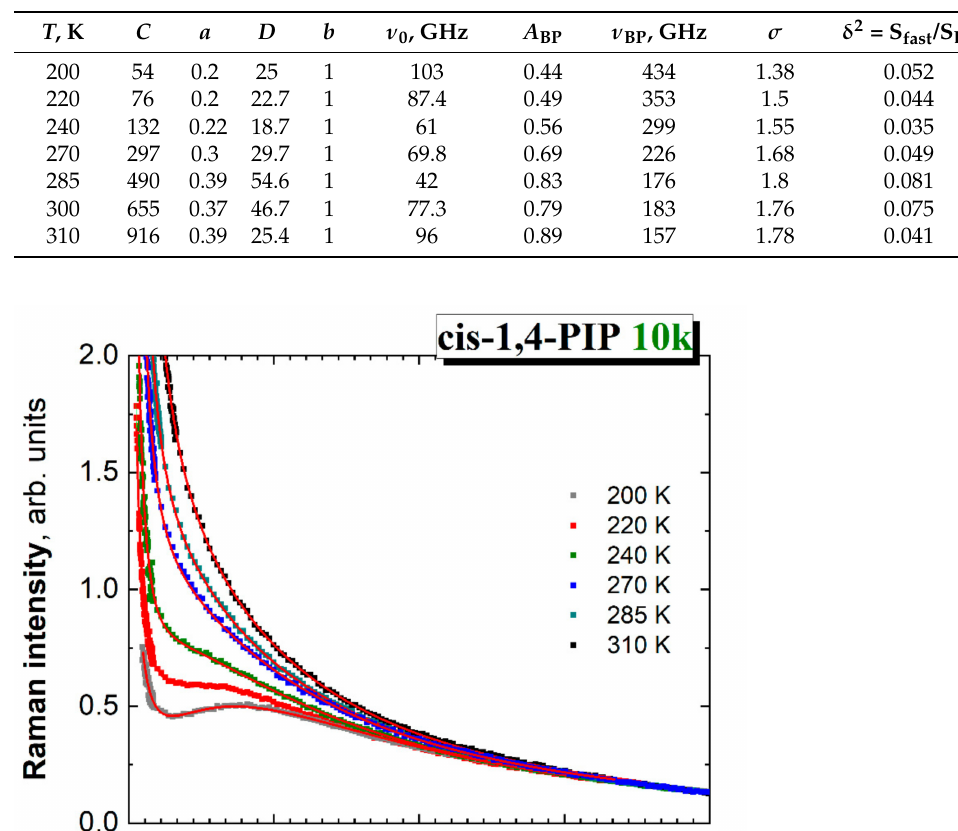
Table 2. Spectral Parameters of the Fit by Equation (6).